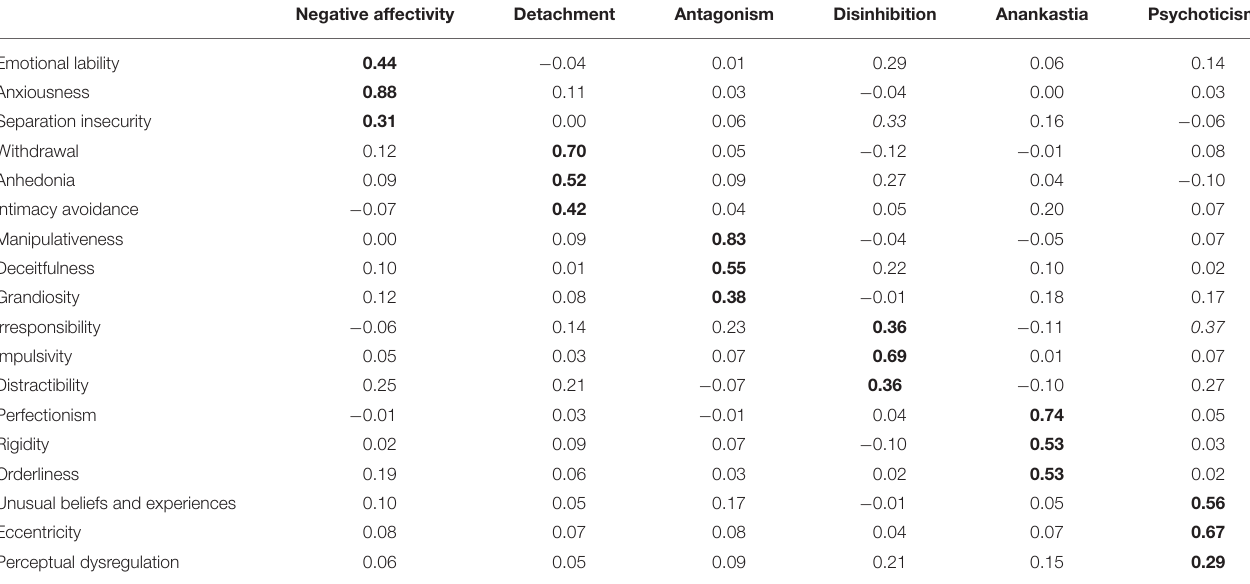
TABLE 1 | Loadings patterns of the facets derived from the extracted version of PID5BF +